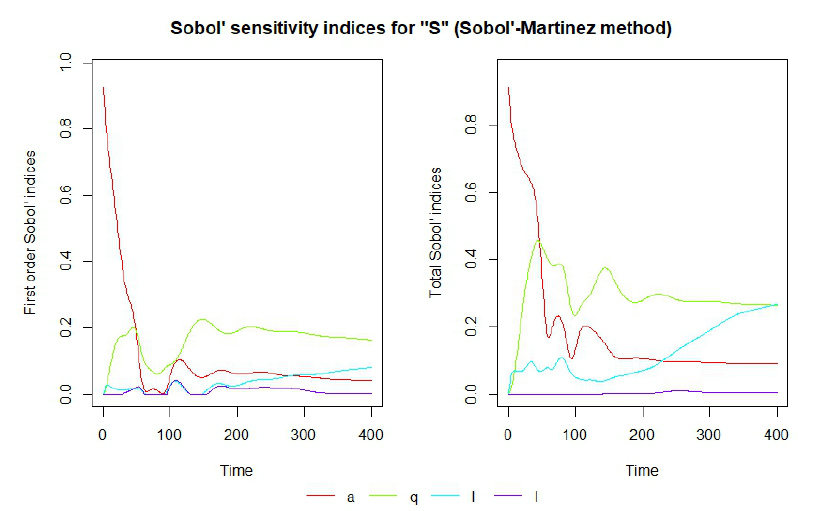
Fig. 4. Sensitivity Analysis: Sensitive Cancer